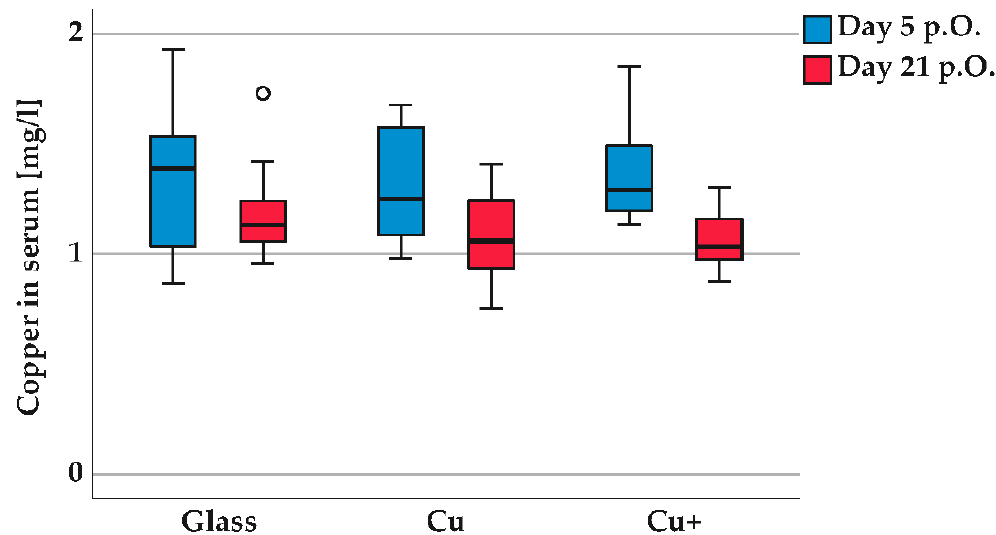
Figure 8. Copper in rat serum on days 5 and 21 after implantation (in mg/L). Groups: glass beads